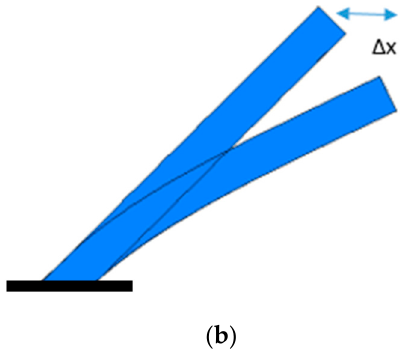
Figure 10. Inclined angle 45 ◦ : ( a ) Flap bending; ( b ) Representation of flap deflection with respect to its initial state, thickness 10 mm Table 2. Deformation across flap orientations.